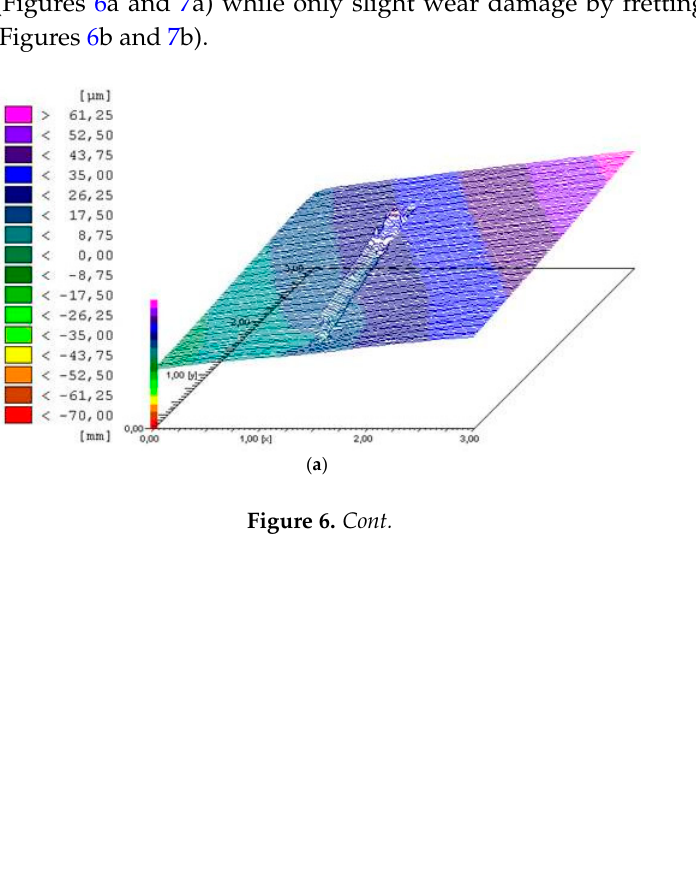
Table 1. Mean (standard deviation) of repassivation times (T re ; ms) from the last scratching cycle for both commercially pure titanium (CP-Ti) and titanium alloys containing 20 mass% chromium (Ti-20Cr) at different scratching Results of statistical analysis are represented by lower and upper case letters. Different lowercase letters in the same column indicate that the groups are significantly different ( p < 0.05). Different upper case letters in the same row indicate that the groups are significantly different ( p < 0.05).